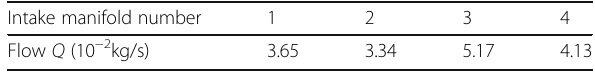
Table 2 Each intake manifold flow Intake manifold